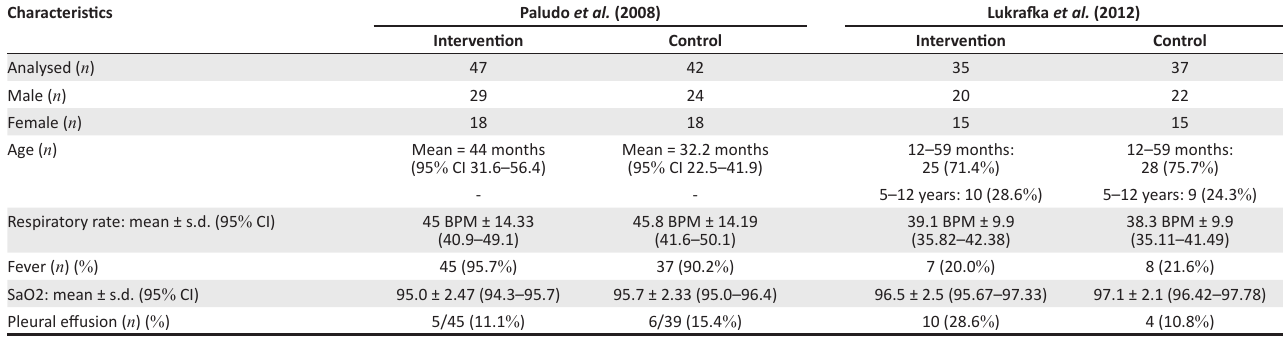
TABLE 2: Baseline characteristics of included studies. Characteristics